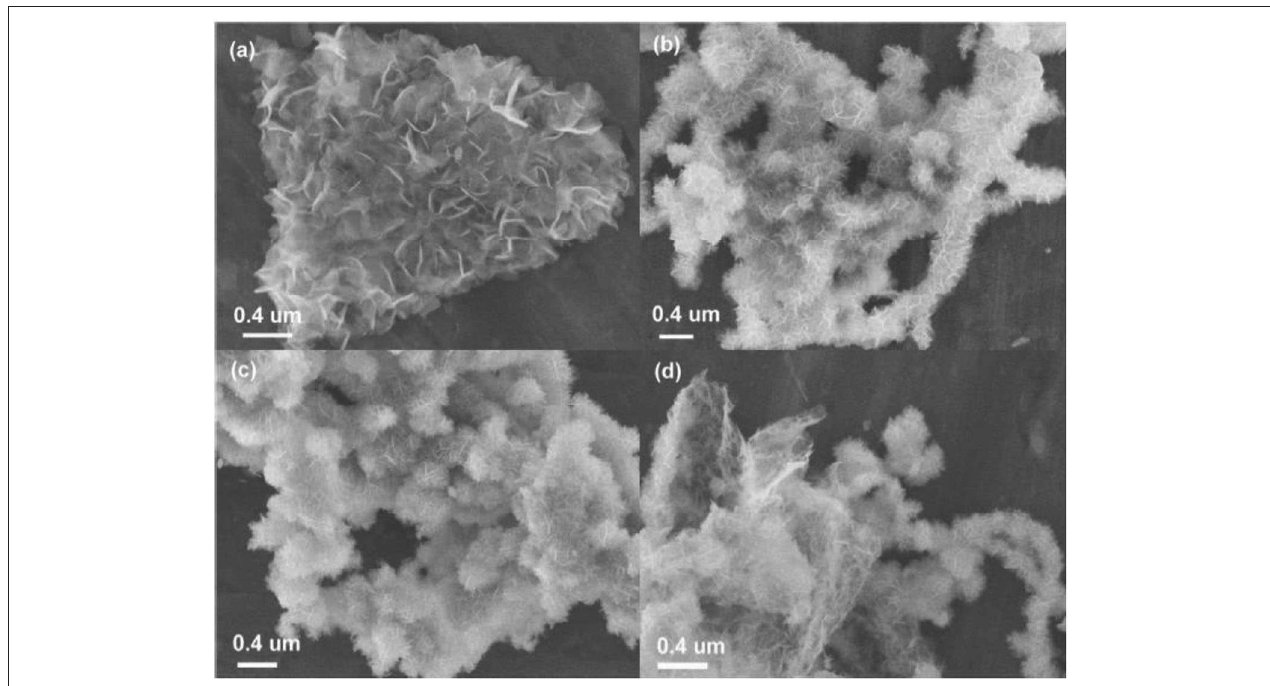
FIGURE 7 | SEM images of (a) Ni-Mn LDHs/rGO, (b) Ni-Mn LDHs/carbon nanotubes, (c) Ni-Mn LDHs/carbon black, and (d) Ni-Mn LDHs/carbon nanotubes/rGO ( Li et al.,